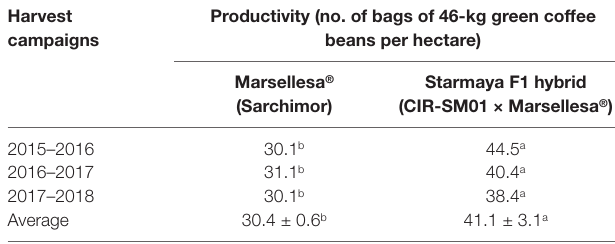
TABLE 5 | Comparison of the productivity of Marsellesa ® and Starmaya cultivars during three harvest campaigns. Harvest